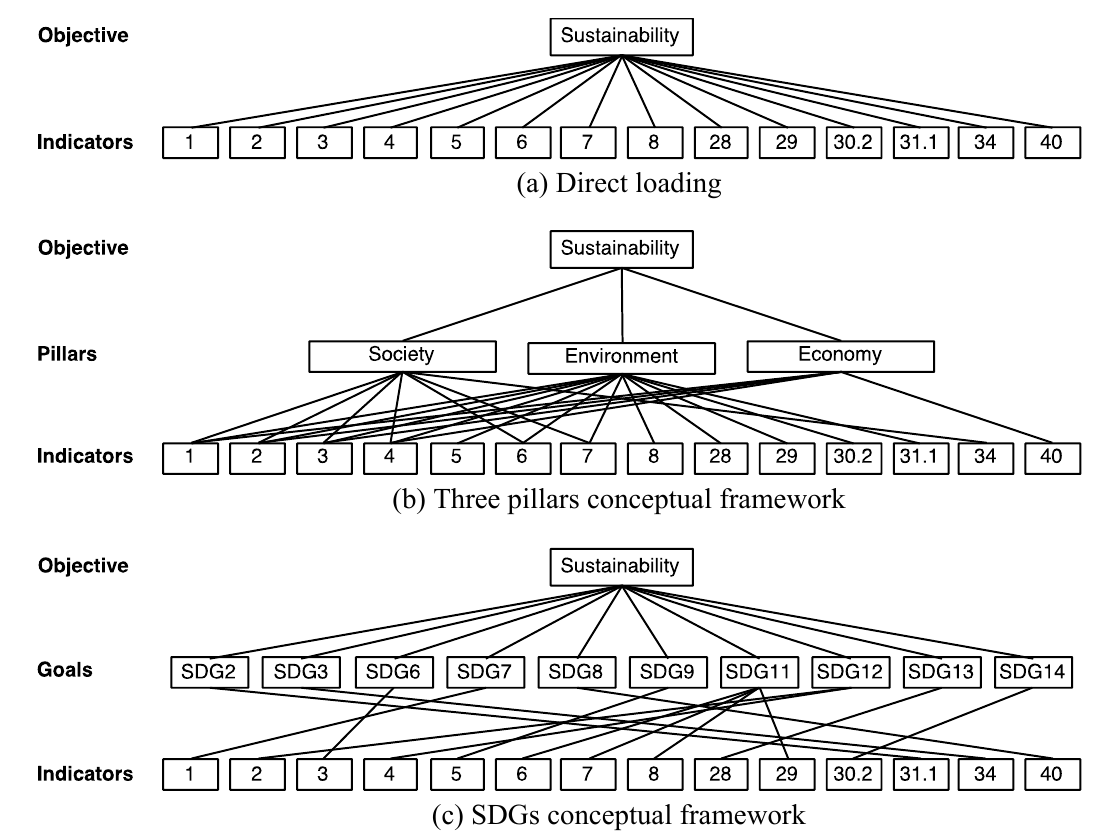
Figure 2. Conceptual frameworks for sustainability with indicator